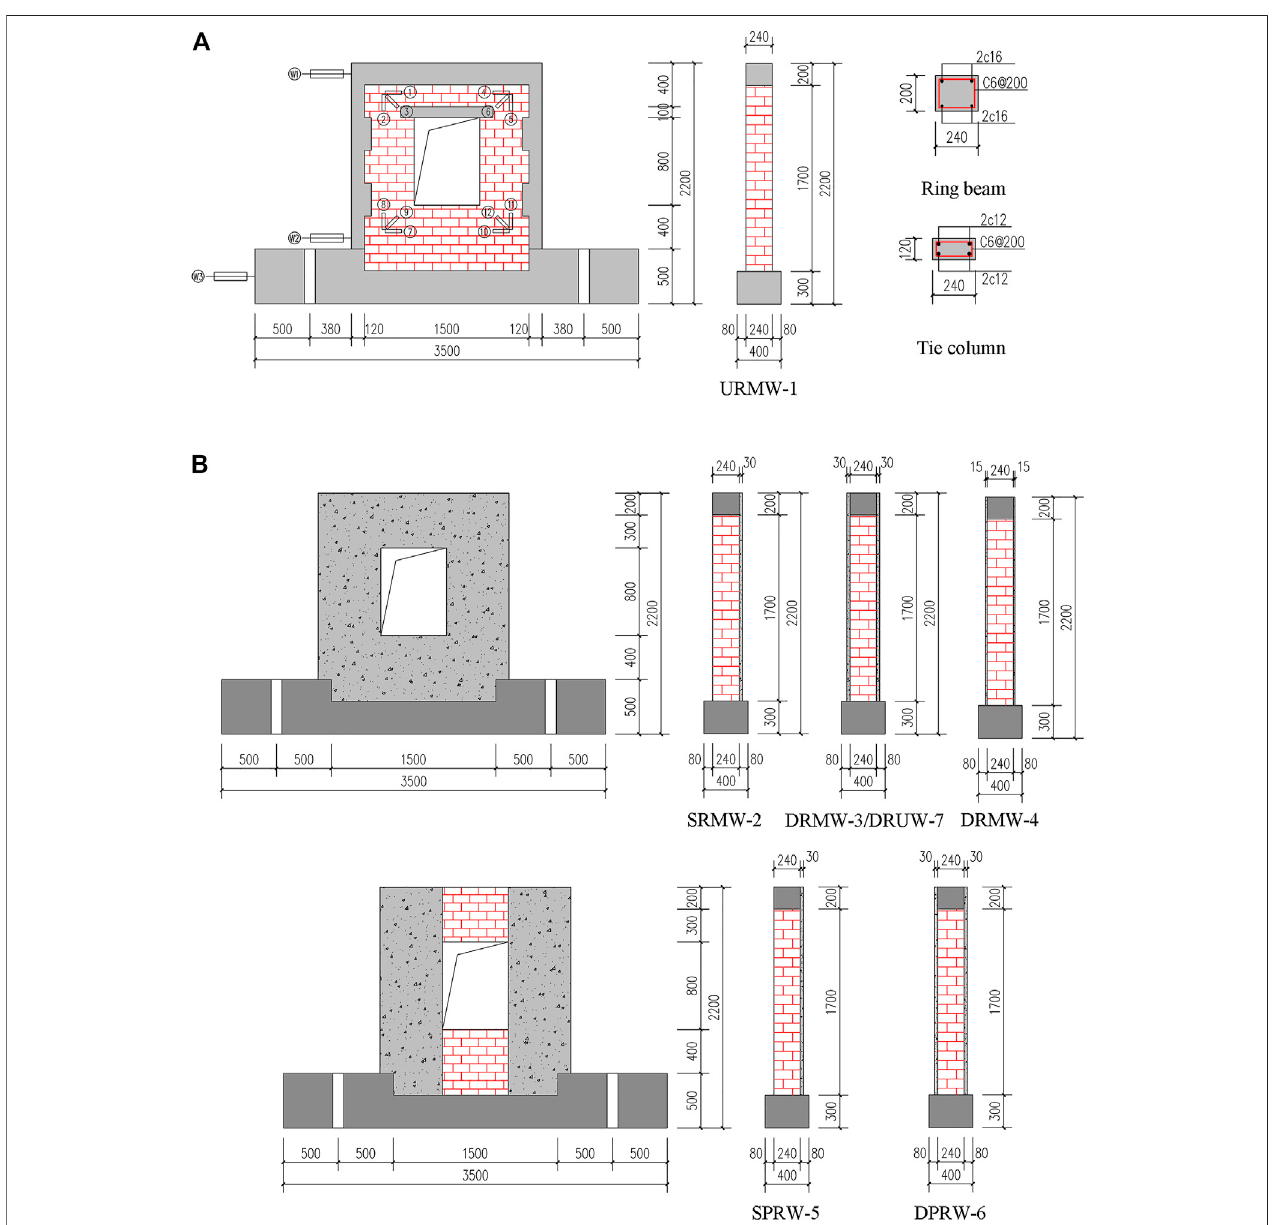
FIGURE 2 | Details of the tested wall (unit: mm) (A) the layout, reinforcement, and facades of tested walls (B) strengthening methods for the tested walls.